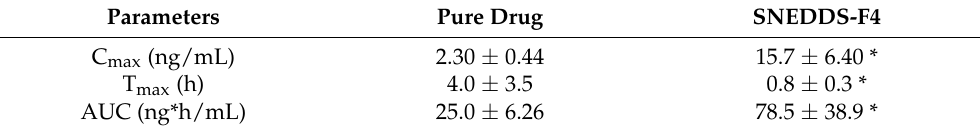
Table 5. Pharmacokinetic parameters of AC1497 following the oral administration of AC1497 in different formulations to rats (mean ± SD, n = 3). The dose was equivalent to 20 mg/kg of AC1497. Parameters